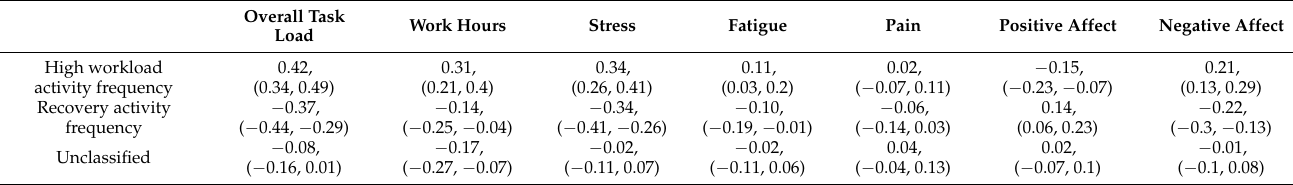
Table 5. Within-person correlations among daily frequency of activity categories and measures of workload and well-being. Values in parentheses represent 95% confidence intervals.